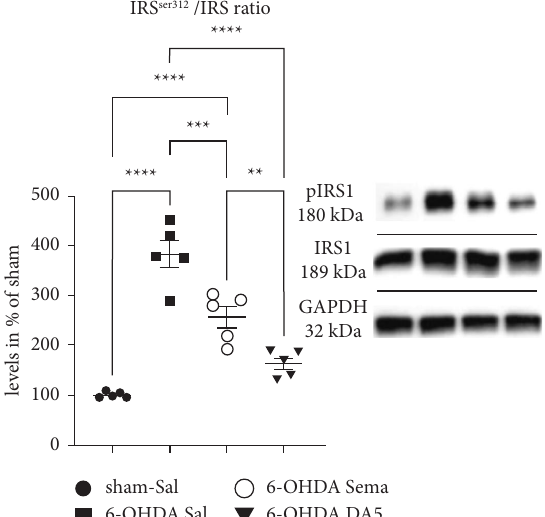
Figure 6: Efects on 6-OHDA-induced insulin resistance in the substantia nigra. Analysis of the IRS/p-IRS-1 ser312 expression ratio in SNpc. Te data represent the means ± SEM of 5 rats per group; one-way ANOVA followed by the Tukey multiple comparisons test; ∗∗∗∗ � p < 0 . 0001; ∗∗∗ � p < 0 . 001; ∗ � p < 0 . 05. Western blot samples are shown. Lane 1: Sham; 2: 6-OHDA; 3: 6-OHDA + Sema; 4: 6- OHDA +